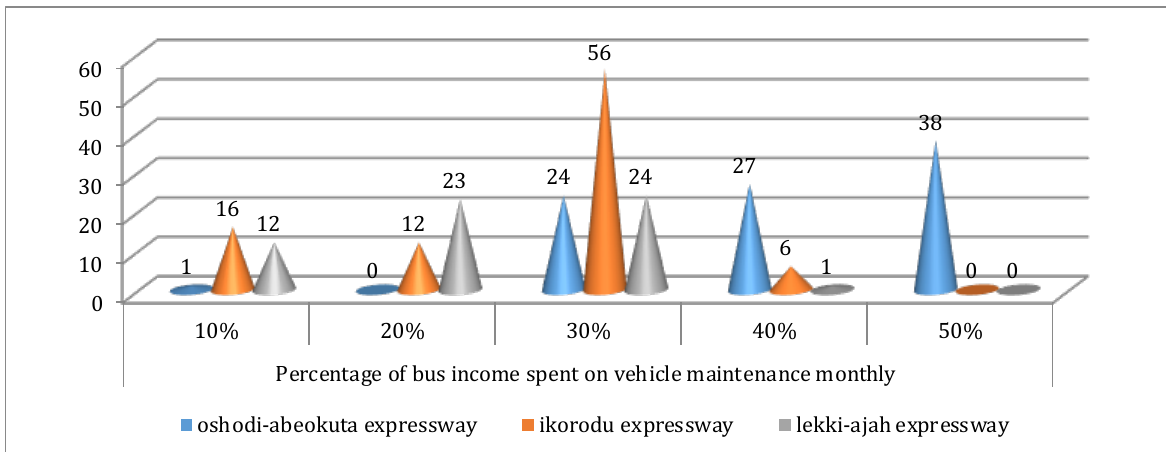
Figure 4: Percentage of Bus Income Spent Monthly on Maintenance by Operators in the study